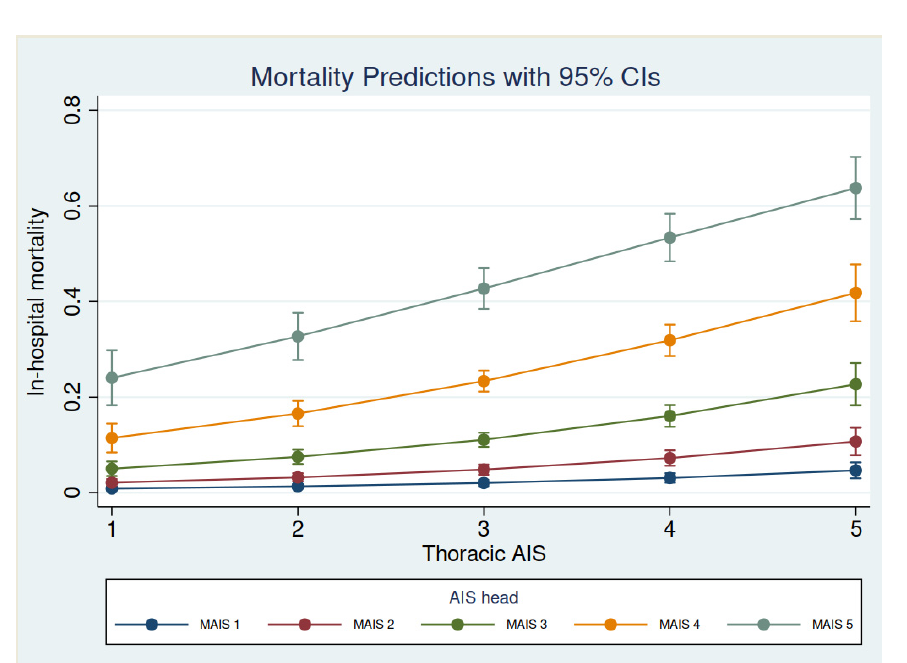
Figure 1. In-hospital mortality prediction in chest trauma according to the severity of head injury. Multiple logistic regression analyses were performed to analyze the risk factors associ- ated with mortality in the severe chest trauma group. Age, the severity of injury evaluated by the NISS and the AIS-head, hemodynamic instability, the need for prehospital intubation, and the development of acute kidney injury and multiorgan failure were